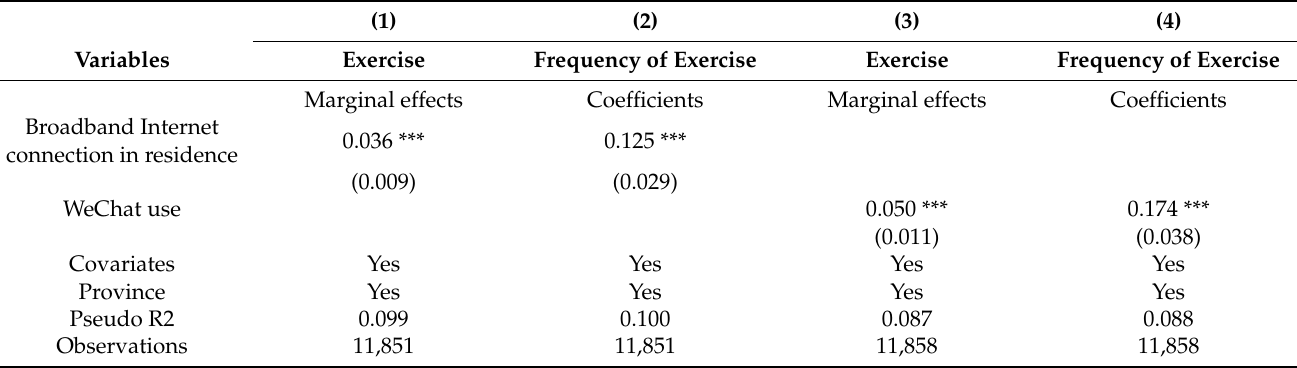
Table 4. Regression results of robustness